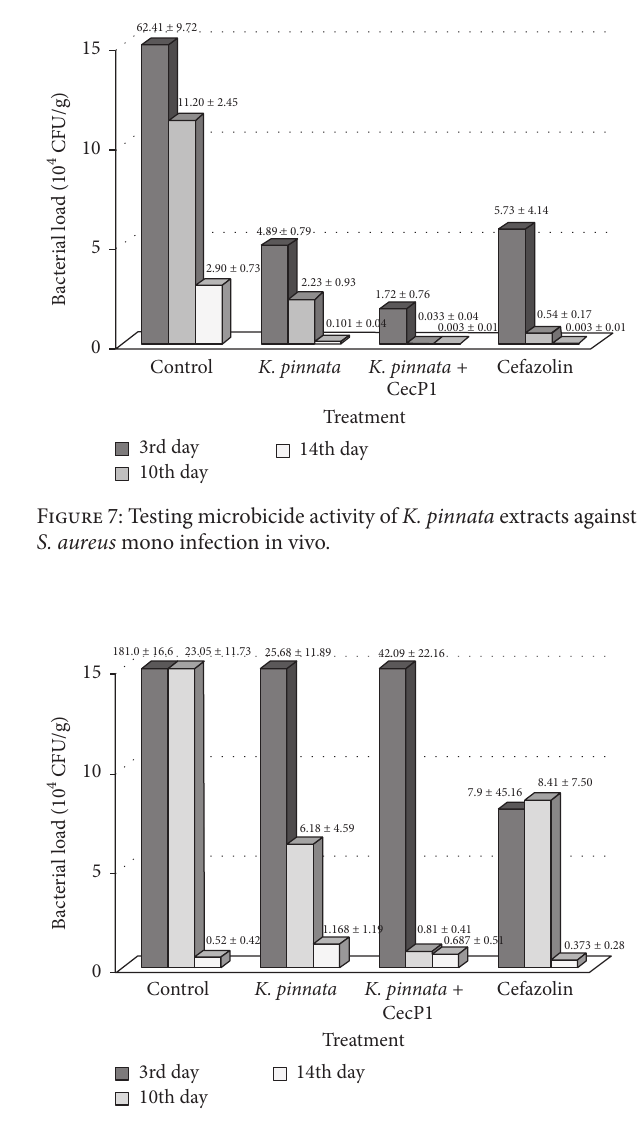
Figure 8: Testing microbicide activity of K. pinnata extracts against combination of S. aureus and P. aeruginosa in